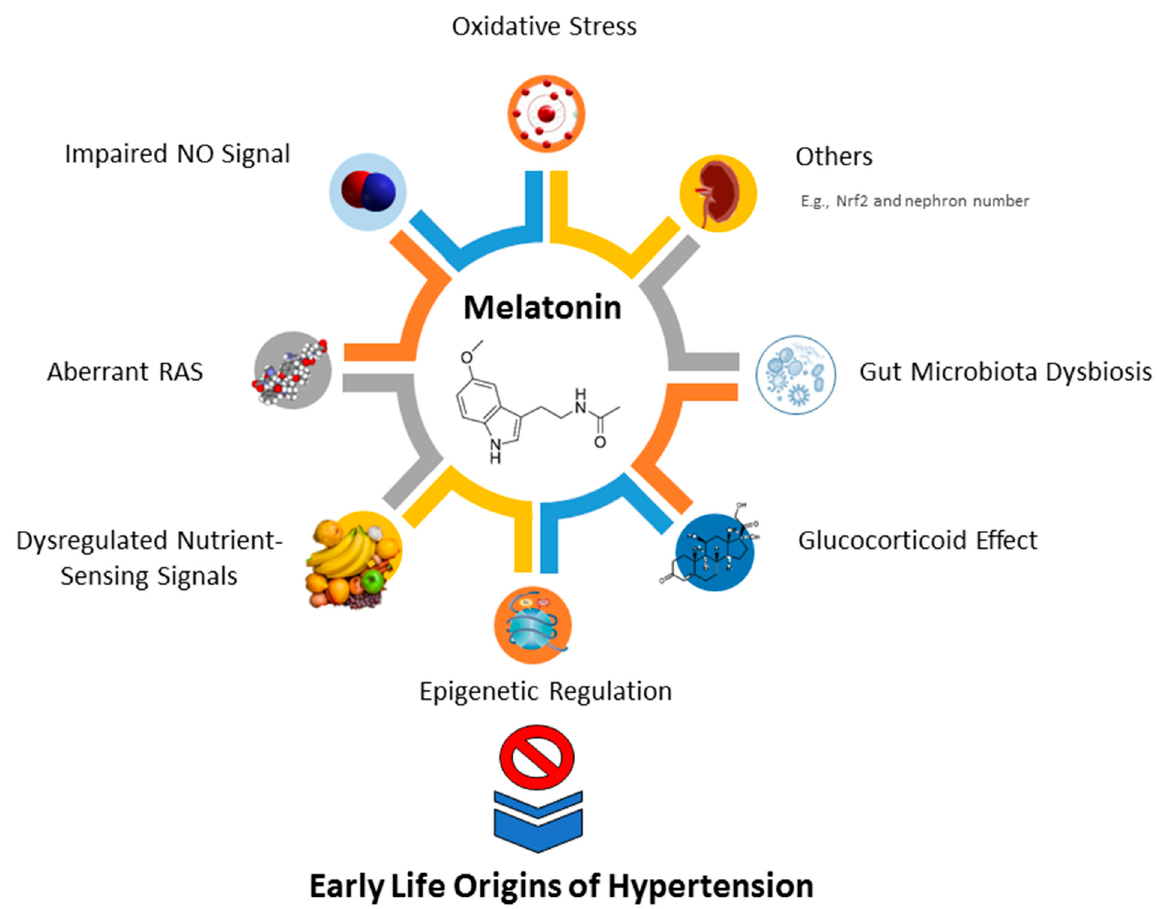
Figure 2. Schema outlining the protective mechanisms of early life melatonin use against early life origins of hypertension. NO = nitric oxide; Nrf2 = nuclear factor erythroid 2-related factor 2; RAS = renin–angiotensin system.